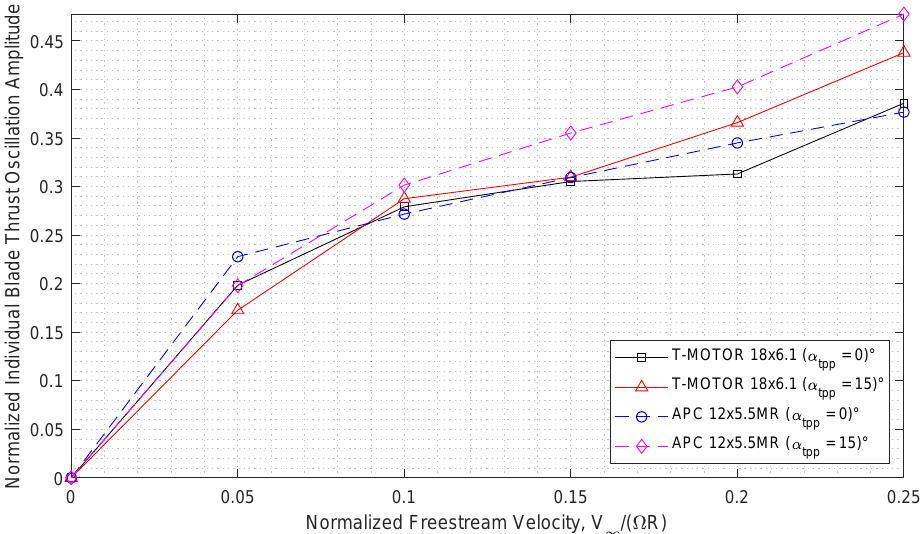
Figure 16. Normalized single blade thrust oscillation amplitude vs. normalized freestream velocity as predicted with the DDE